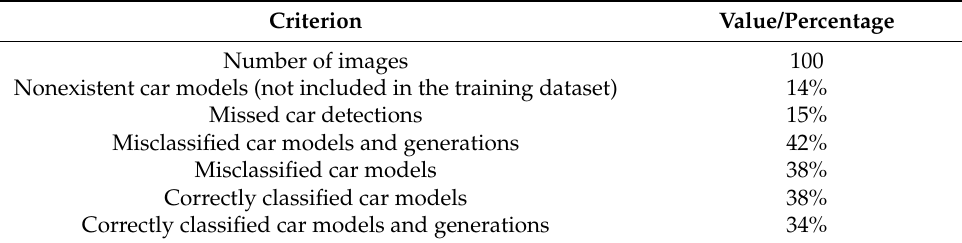
Table 8. Evaluation of the car recognition model on a set of images.